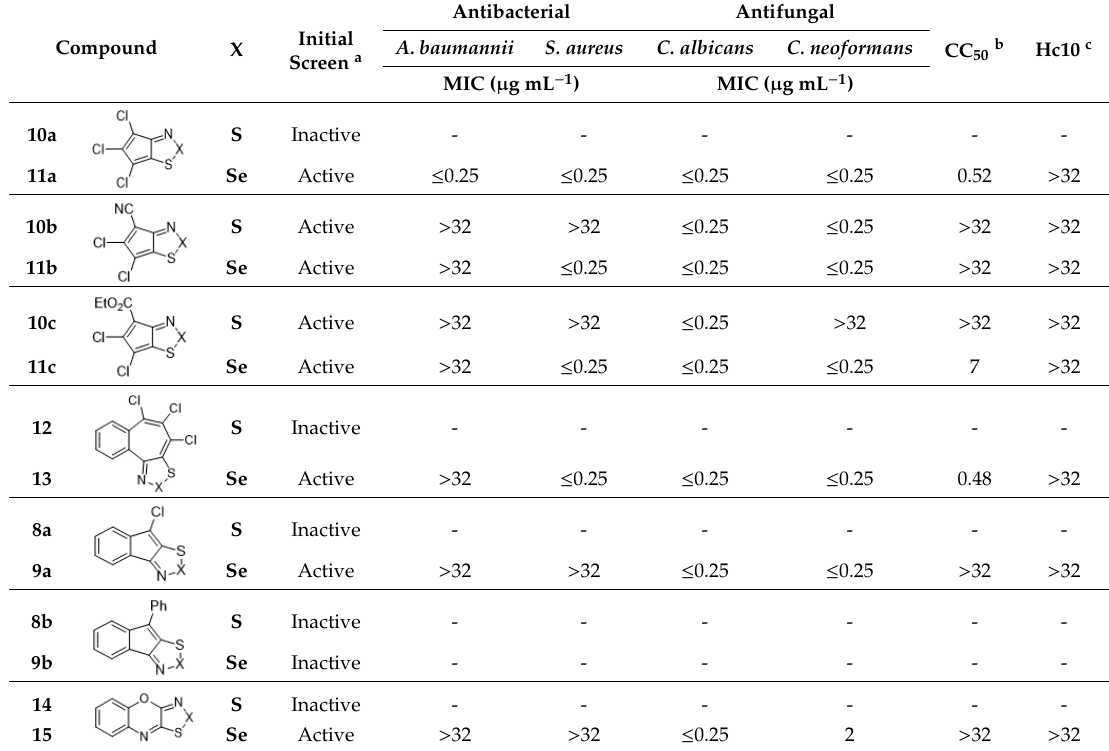
Table 1. Antibacterial and antifungal activity of 8 − 15 .